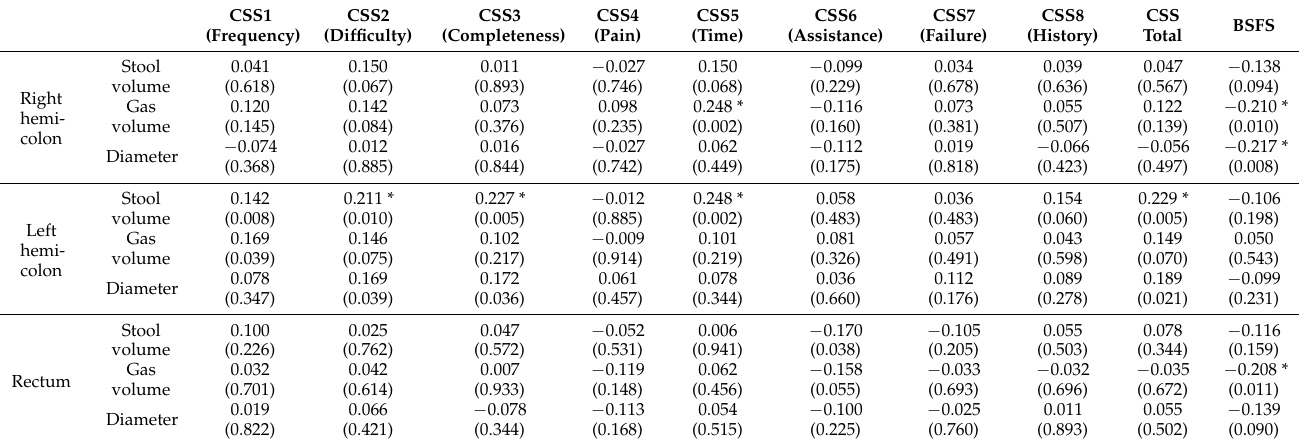
Table 3. Correlation between results of evaluation of CT images and constipation symptoms. Rho ( p -value).